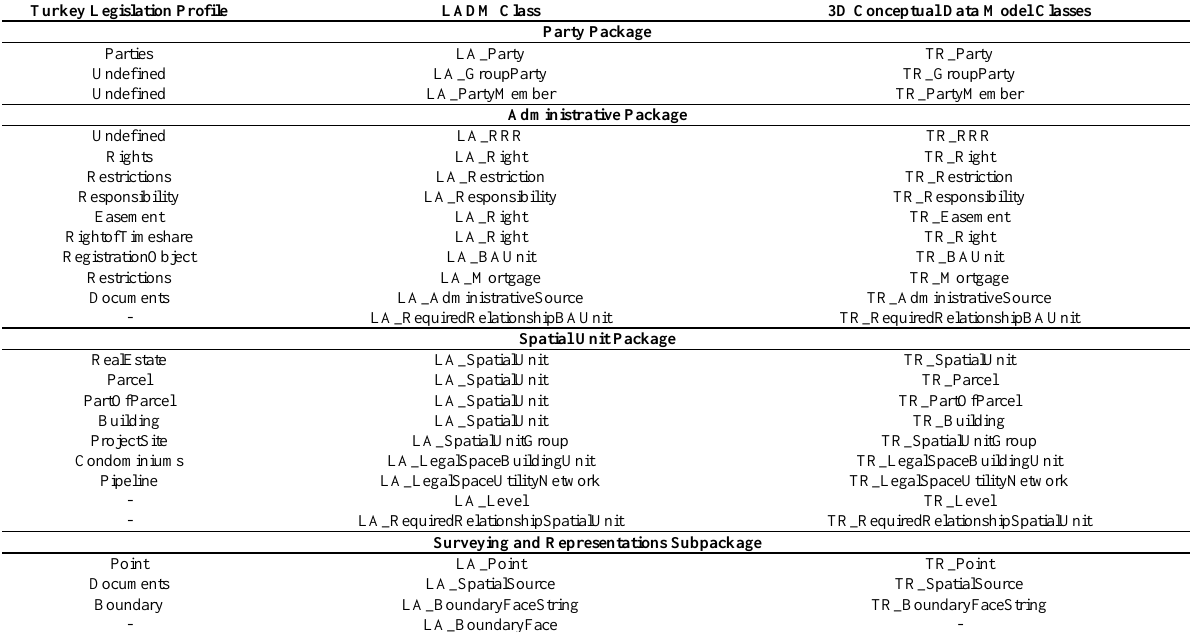
Table 2. Comparison of LADM classes with the proposed new 3D conceptual data model